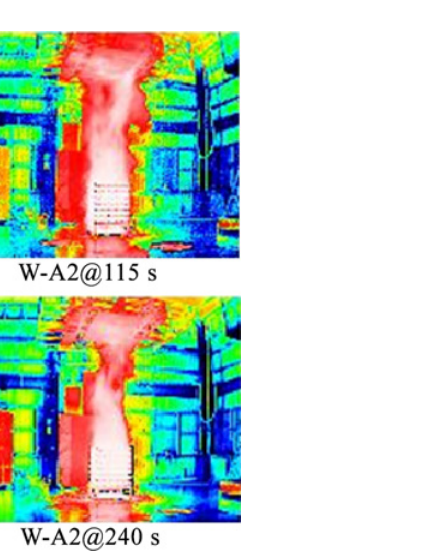
Fig 14. Temperature distribution of experiment results (for Case W-A2).